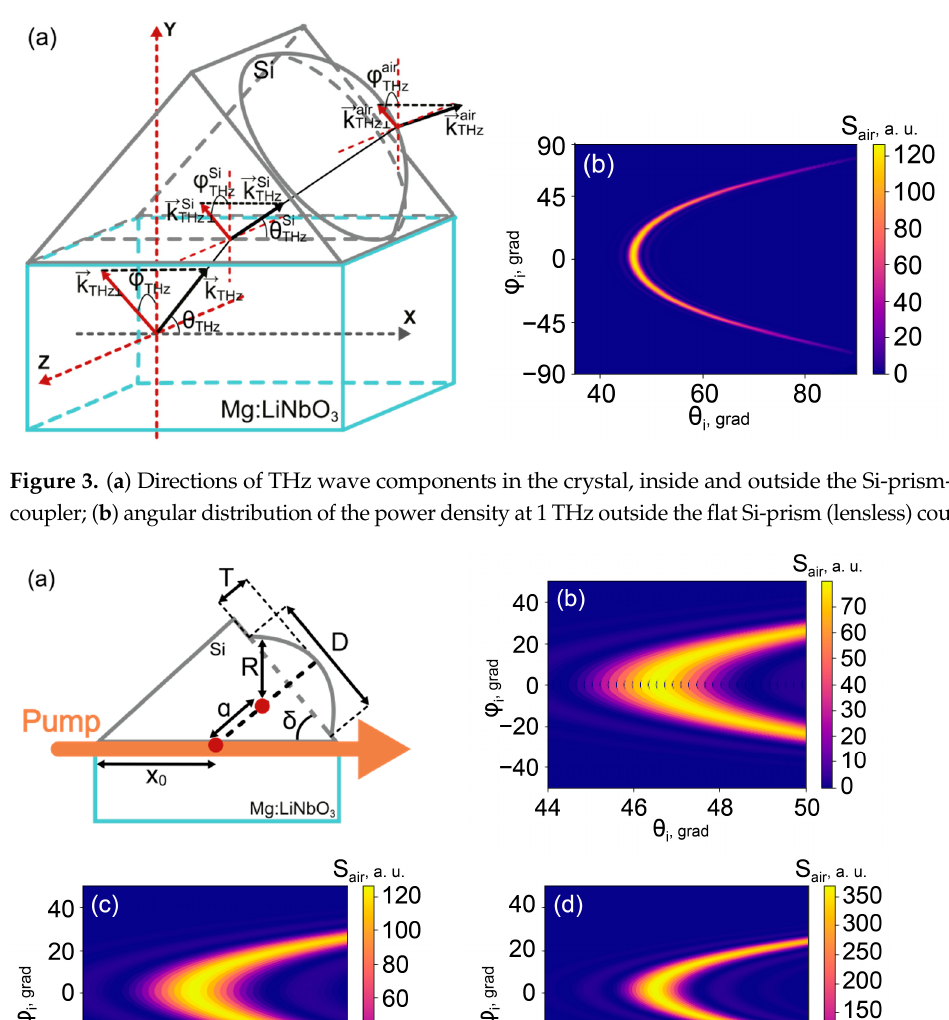
Figure 4. ( a ) Sketch for the calculation of the lens parameter ζ ≡ a / R ; ( b – d ) calculated angular distributions of 1 THz radiation power in the air after passing the prism-lens coupler with ζ = 1.2 ( b ), ζ = 1 ( c ), and ζ = 0.68 ( d ).